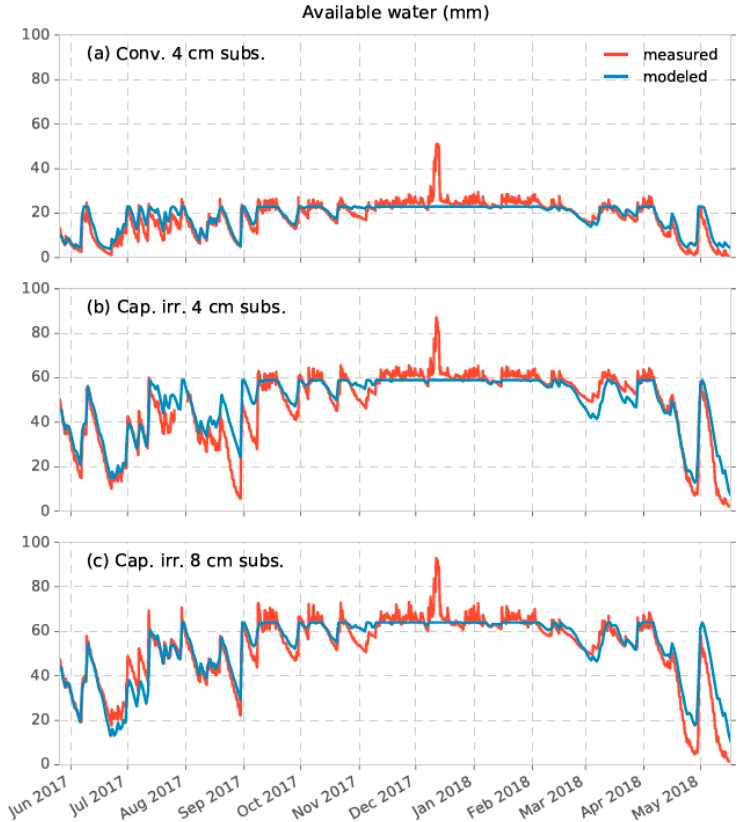
Figure 7. Measured and modeled daily water availability during the measurement period. Water availability was measured by subtracting the dead weight of the lysimeters from the total weight of the lysimeters over time. The measured peak in available water on 10 December 2017 is related to a heavy snowfall event that resulted in a strong increase of the lysimeter weight.